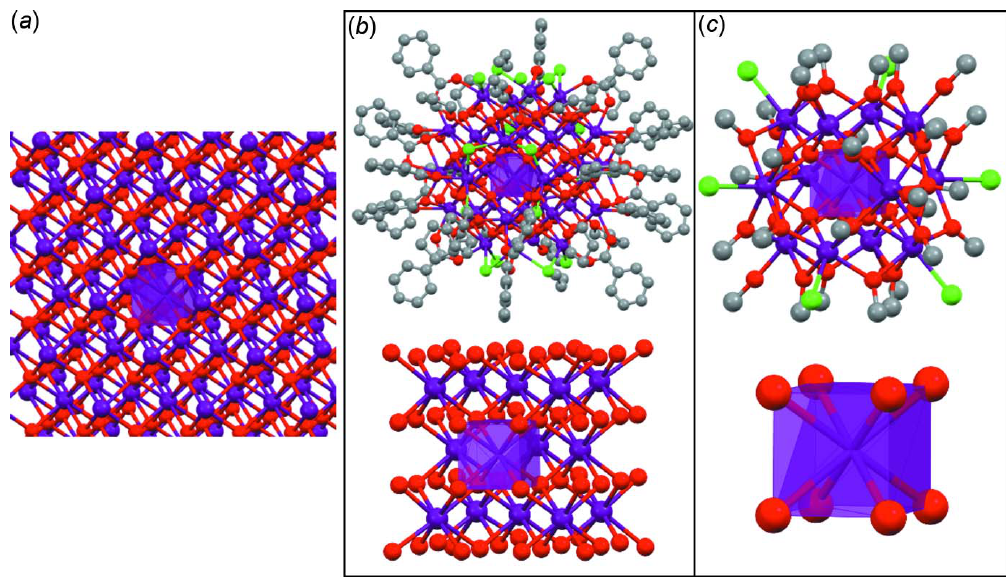
Figure 3 Cubic coordination polyhedra of uranium (dark purple polyhedra) in different compounds: ( a ) bulk UO 2 (Cooper, 1982), ( b ) the {U 38 } cluster (Falaise et al. , 2013 c ), and ( c ) the {U 13 } cluster ( I ). The structure of I is drawn as [U 13 ( (cid:2) 4 -O oxo ) 8 Cl 6 (MeO) 32 ] in order to omit the disorder between chloride and methoxide anions for clarity. Colour code: carbon, black; oxygen, red; chlorine, light green; uranium, dark purple. Hydrogen atoms are omitted for clarity in ( b ) and ( c ).